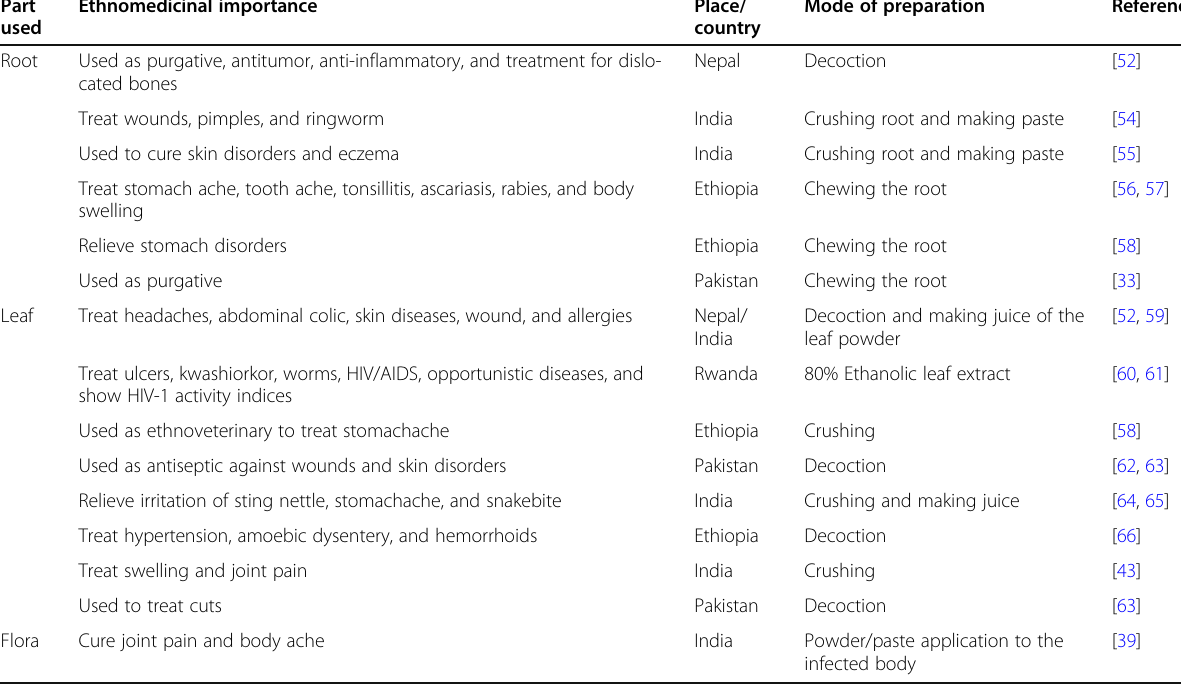
Table 2 Ethnomedicinal importance of R. nepalensis and its mode of preparation for treatment of different ailments Part